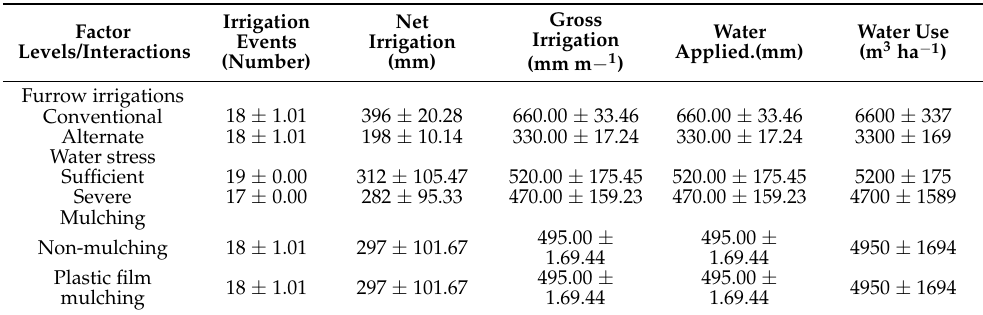
Figure 2. Gross irrigation water used under different irrigation methods (IM), water stress (WS), and mulching practice (MP) throughout the base period during 2020–2021. T 1 , T 2 , T 3 , T 4 , T 5 , T 6 , T 7, and T 8 indicate the combined factor treatments. Table 3. Factor effects on irrigation interval, irrigation events, water application, and water use. The data represent means ± SE.